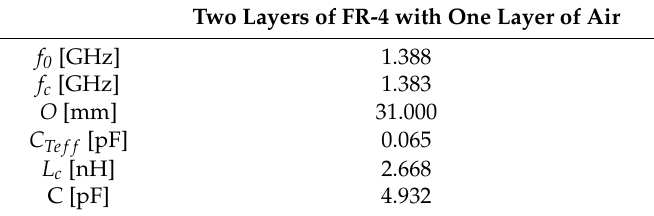
Table 5. Results obtained for the calculation of L and Table 5 . Results obtained for the calculation of L and C.